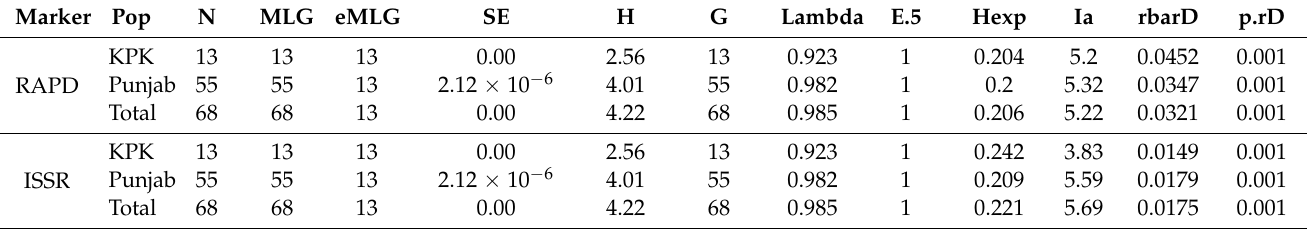
Table 8. Summary statistic of mean genetic parameters based on RAPD and ISSR analysis of T. indica isolates.